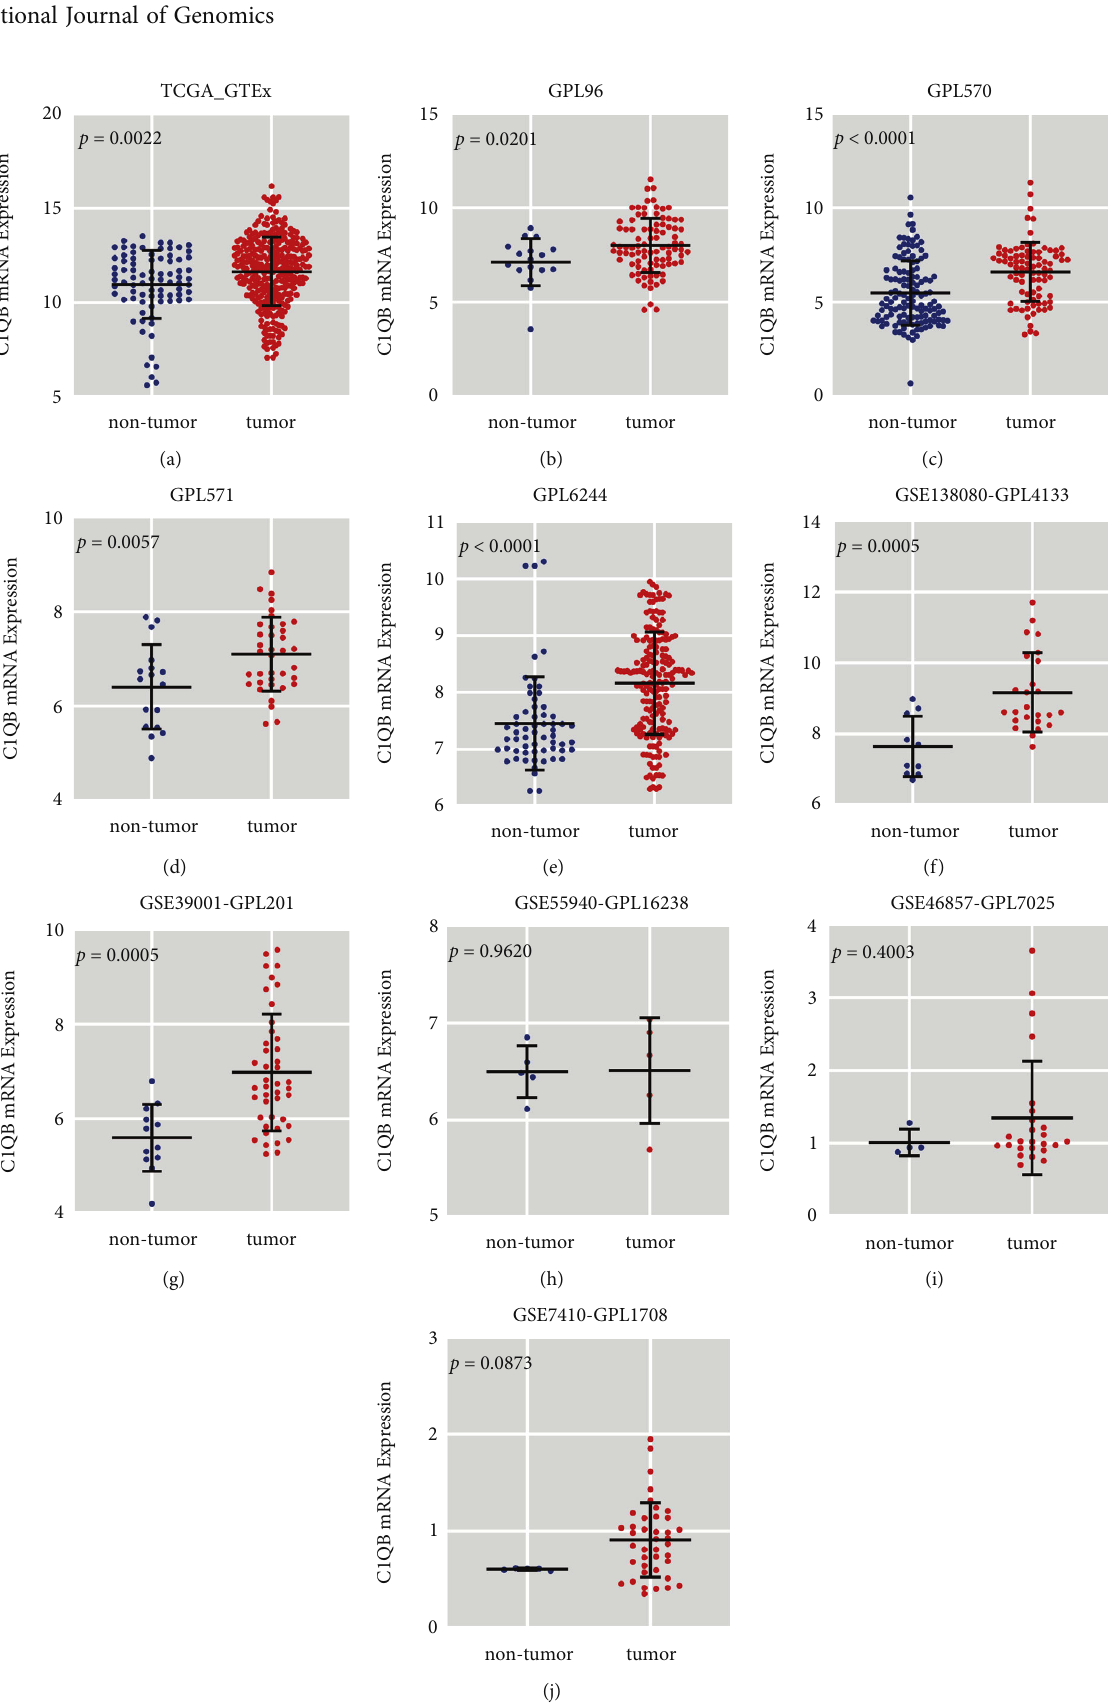
Figure 4: The scatter plots of C1QB mRNA expression in cervical cancer tissues and corresponding non-tumor cervical